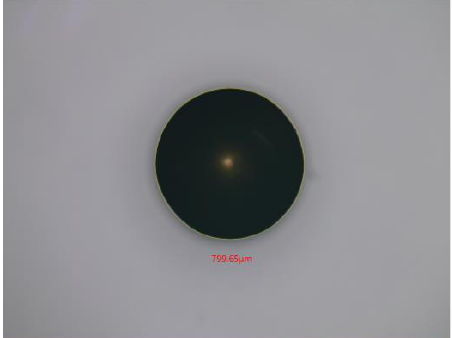
Figure 12. The microphotograph of 800 µm copper particles.